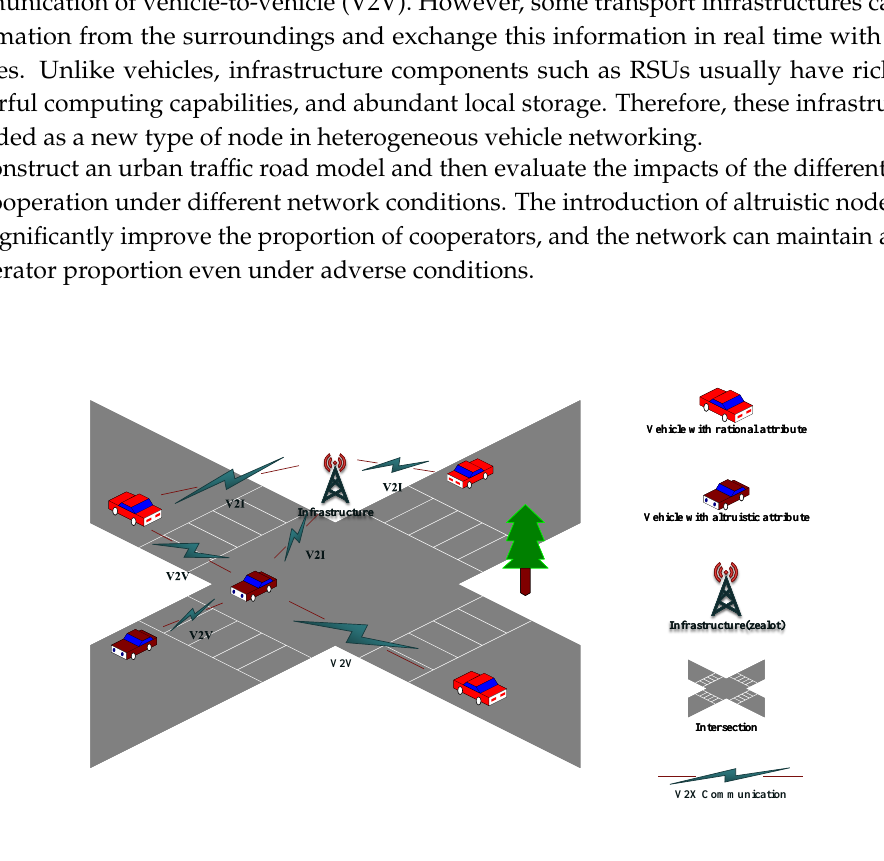
Figure 1. System